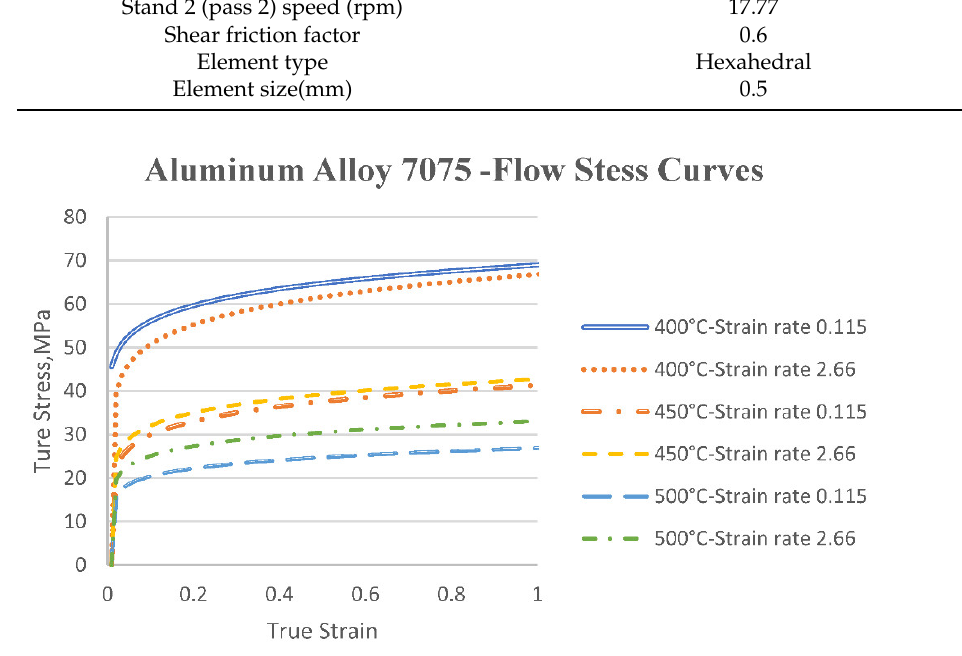
Figure 3. FEM model of the wire billet and the boundary conditions.